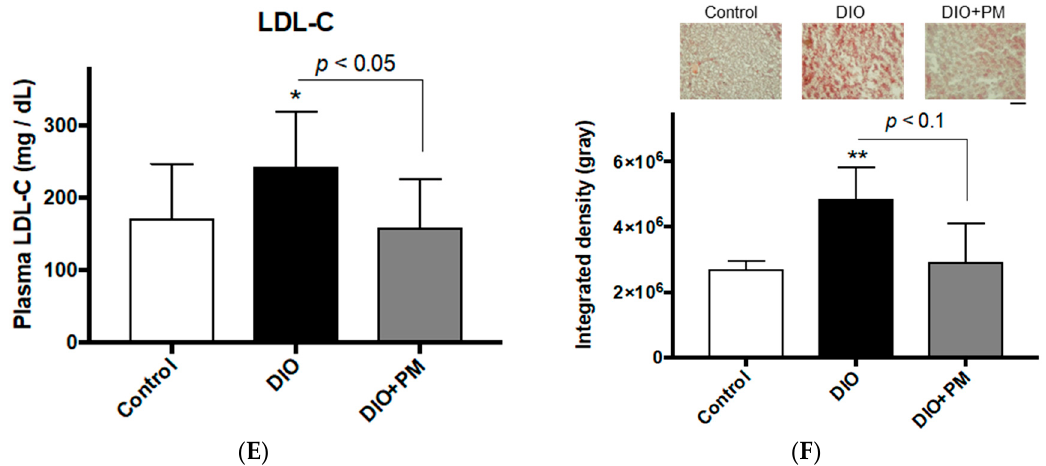
Figure 1. Post-administration of Palmaria mollis (PM) in overfed diet-induced obese (DIO)-zebrafish. ( A ) Schedule of PM supplementation in zebrafish Experiment 1. Overfeeding and PM supplementation started on week 0 and 2, respectively. ( B ) Body weight change during Experiment 1. ( C ) Volume of visceral adipose tissues (VAT) in week 6. ( D – E ) PM suppressed increases in plasma triacylglycerol (TG; D ) and low-density lipoprotein cholesterol (LDL-C; E ) in DIO-zebrafish. ( F ) Lipid accumulation in liver tissues. Lipid droplets (red spots) increased in DIO-zebrafish compared to control. Lower graph indicates the quantification of red signals. * p < 0.05, ** p < 0.01 vs. control. n = 7–10, error bars indicate standard deviations (SD).